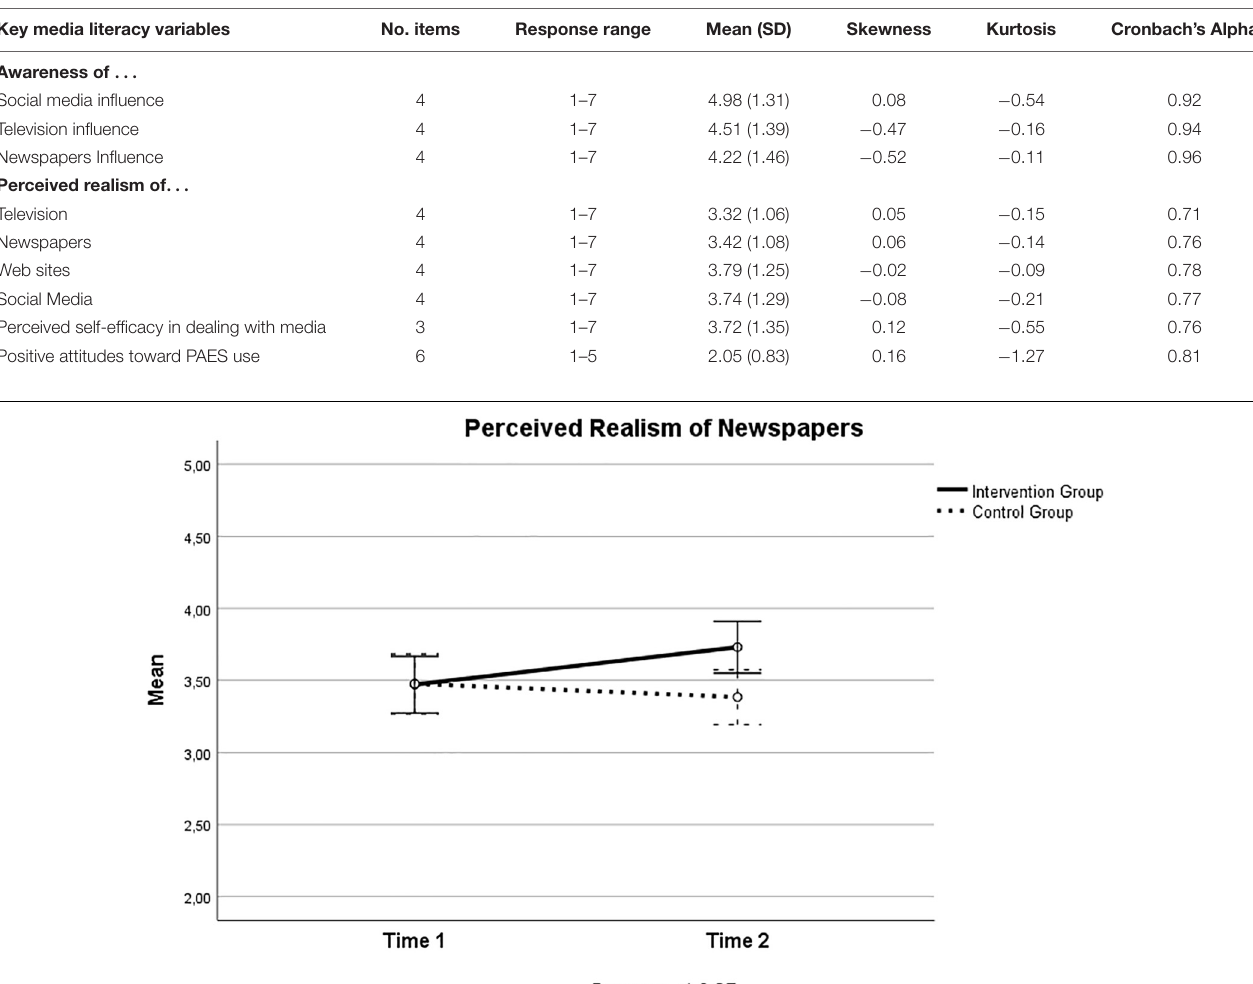
TABLE 1 | Descriptive statistics of the key measures of the study derived from the descriptive sample ( n = 521).